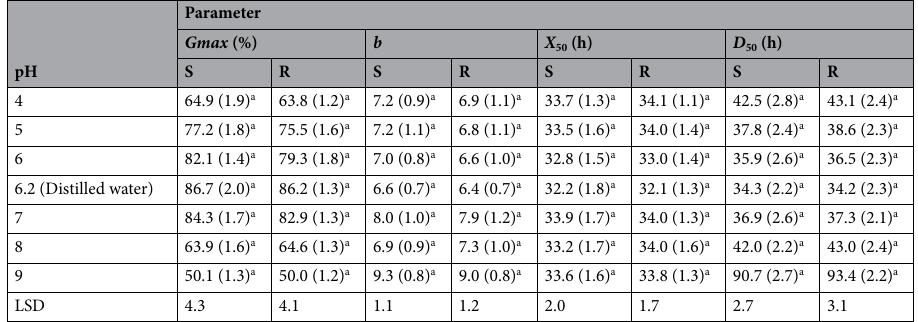
Asn-2041-Ile mutation in the ACCase encoding gene did not affect the germination response of winter wild oat to various temperatures, and germination percentage and rate of the resistant biotype was similar to the susceptible one in all temperature treatments. This is in accordance with the results reported by Travlos 22 , in which no difference was observed between the resistant and susceptible winter wild oat populations when incubated at various temperature regimes. However, ACCase -resistant Asia Minor bluegrass ( Polypogon fugax Nees ex Steud.) biotype had a lower germination percentage compared with the susceptible biotype. The authors pertained the lower germination of resistant biotypes to the fitness cost imposed by Asn-2041-Ile mutation 35 , which is in contrast with the findings of the present study. The germination response of resistant and susceptible biotypes of wild oat under various osmotic potentials was similar. Both biotypes were able to germinate in a wide range of water potentials, indicating the ability of winter wild oat to infest croplands located in different climatic conditions from arid to humid. Water stress is shown to have negative effects on the germination of many weed species such as junglerice ( Echinochloa colona (L.) Link) 36 , sourgrass ( Digitaria insularis ) 17 , Tausch’s goatgrass ( Aegilops tauschii Coss.) 37 , etc. Wu et al. 15 reported that the germination of fenoxaprop-P ethyl-resistant Japanese foxtail biotypes with Trp-1999-Ser mutation was similar to the susceptible biotype under various water stress conditions. Conversely, germination of a glyphosate- resistant Italian ryegrass population plummeted far more than that of the susceptible population, indicating a fitness cost 38 .